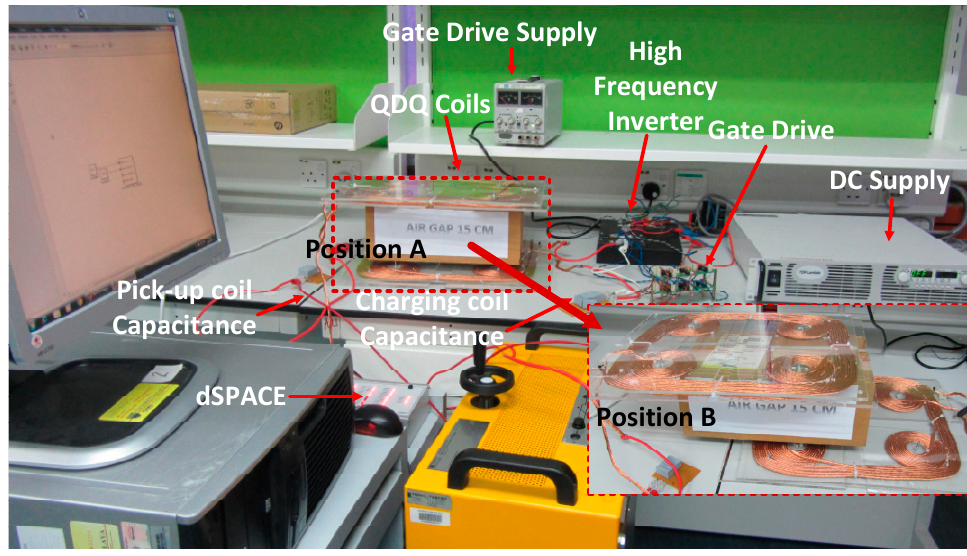
Figure 5. Experimental set-up of the inductive power transfer (IPT) system.